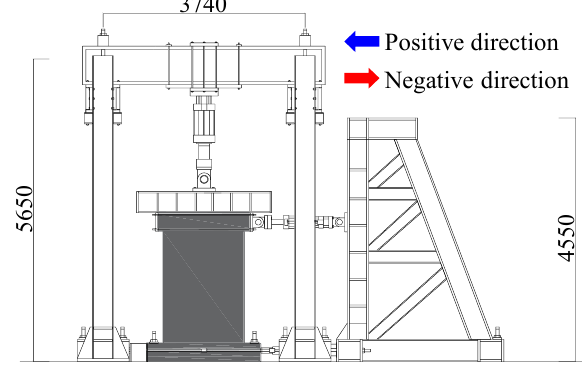
Figure 4. Test setup (unit: mm).